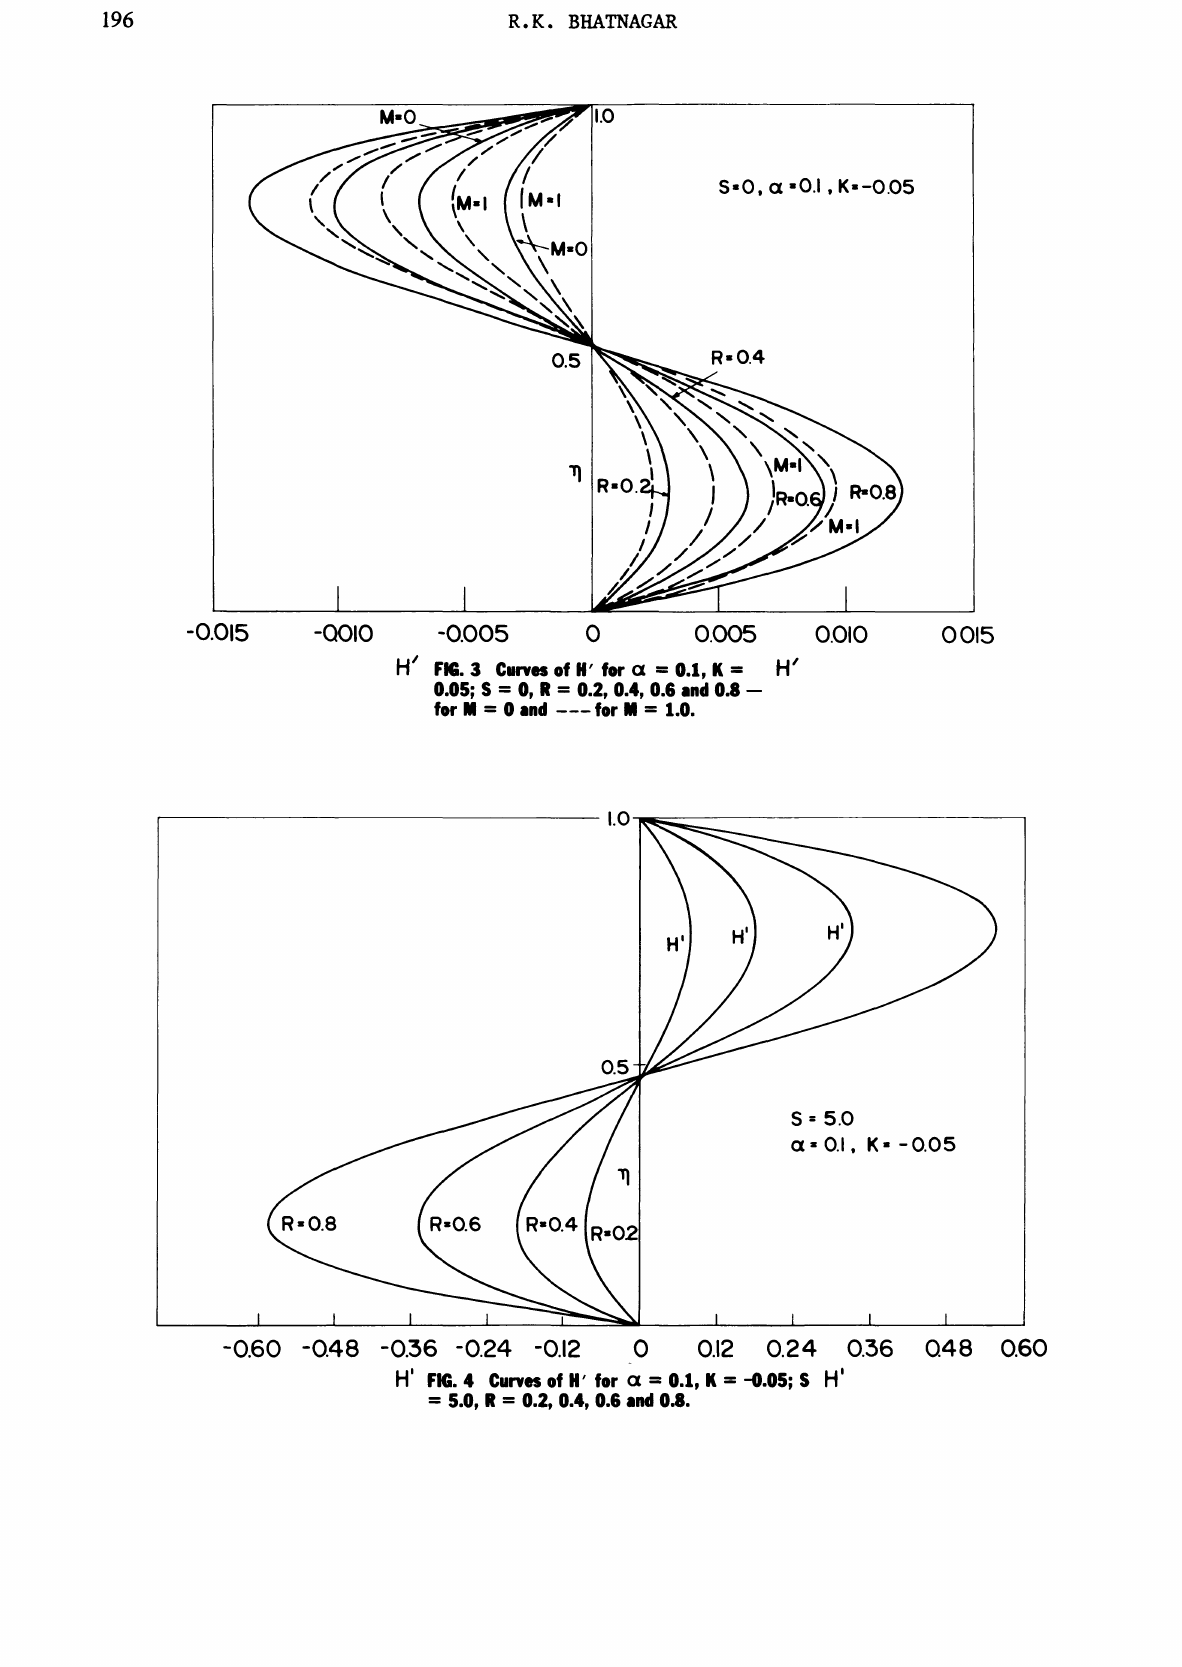
H’ FIG. 4 Curves of H’ for